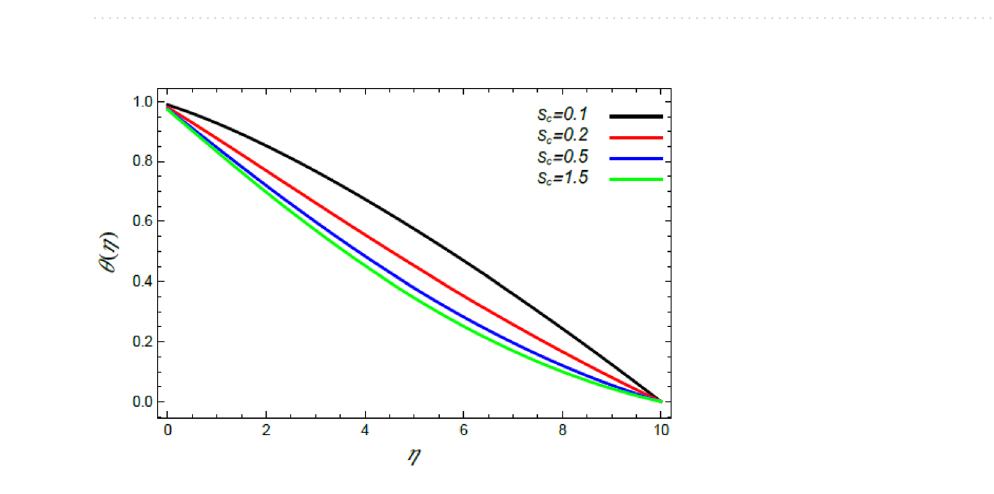
Figure 18. Deviation of the heat profile θ(η) versus η as given in Eq. (66) to illustrate the impact of the heat dispersion factor (cid:31) 1 .